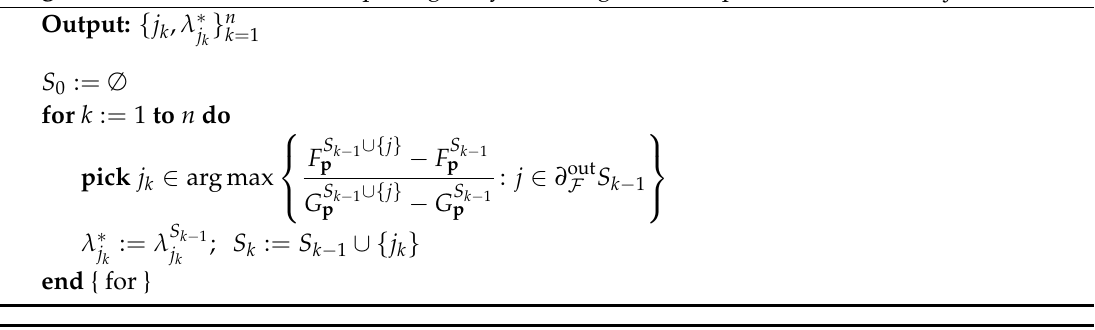
Algorithm 3: Reformulated adaptive-greedy index algorithm: top-down version AG TD F .